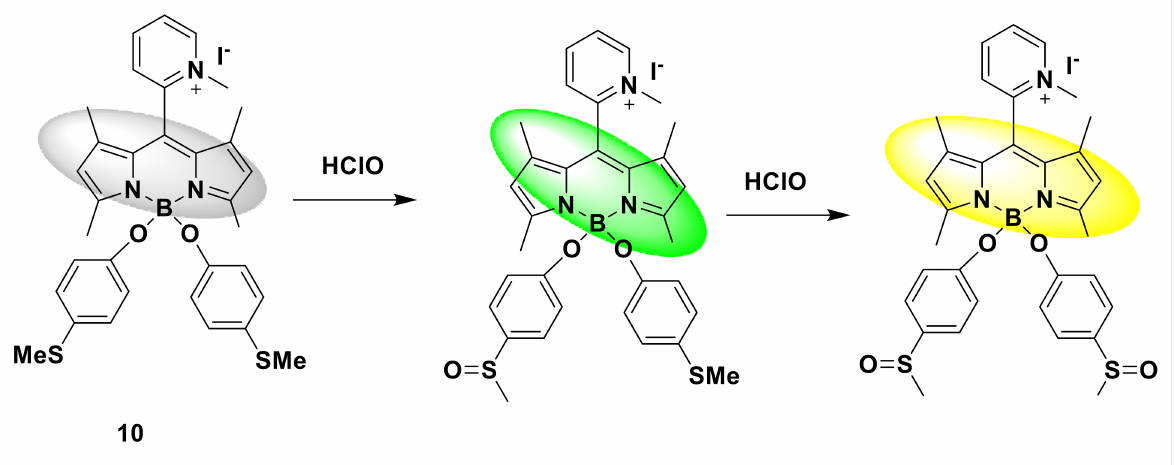
Figure 11. The reaction of probe 10 and